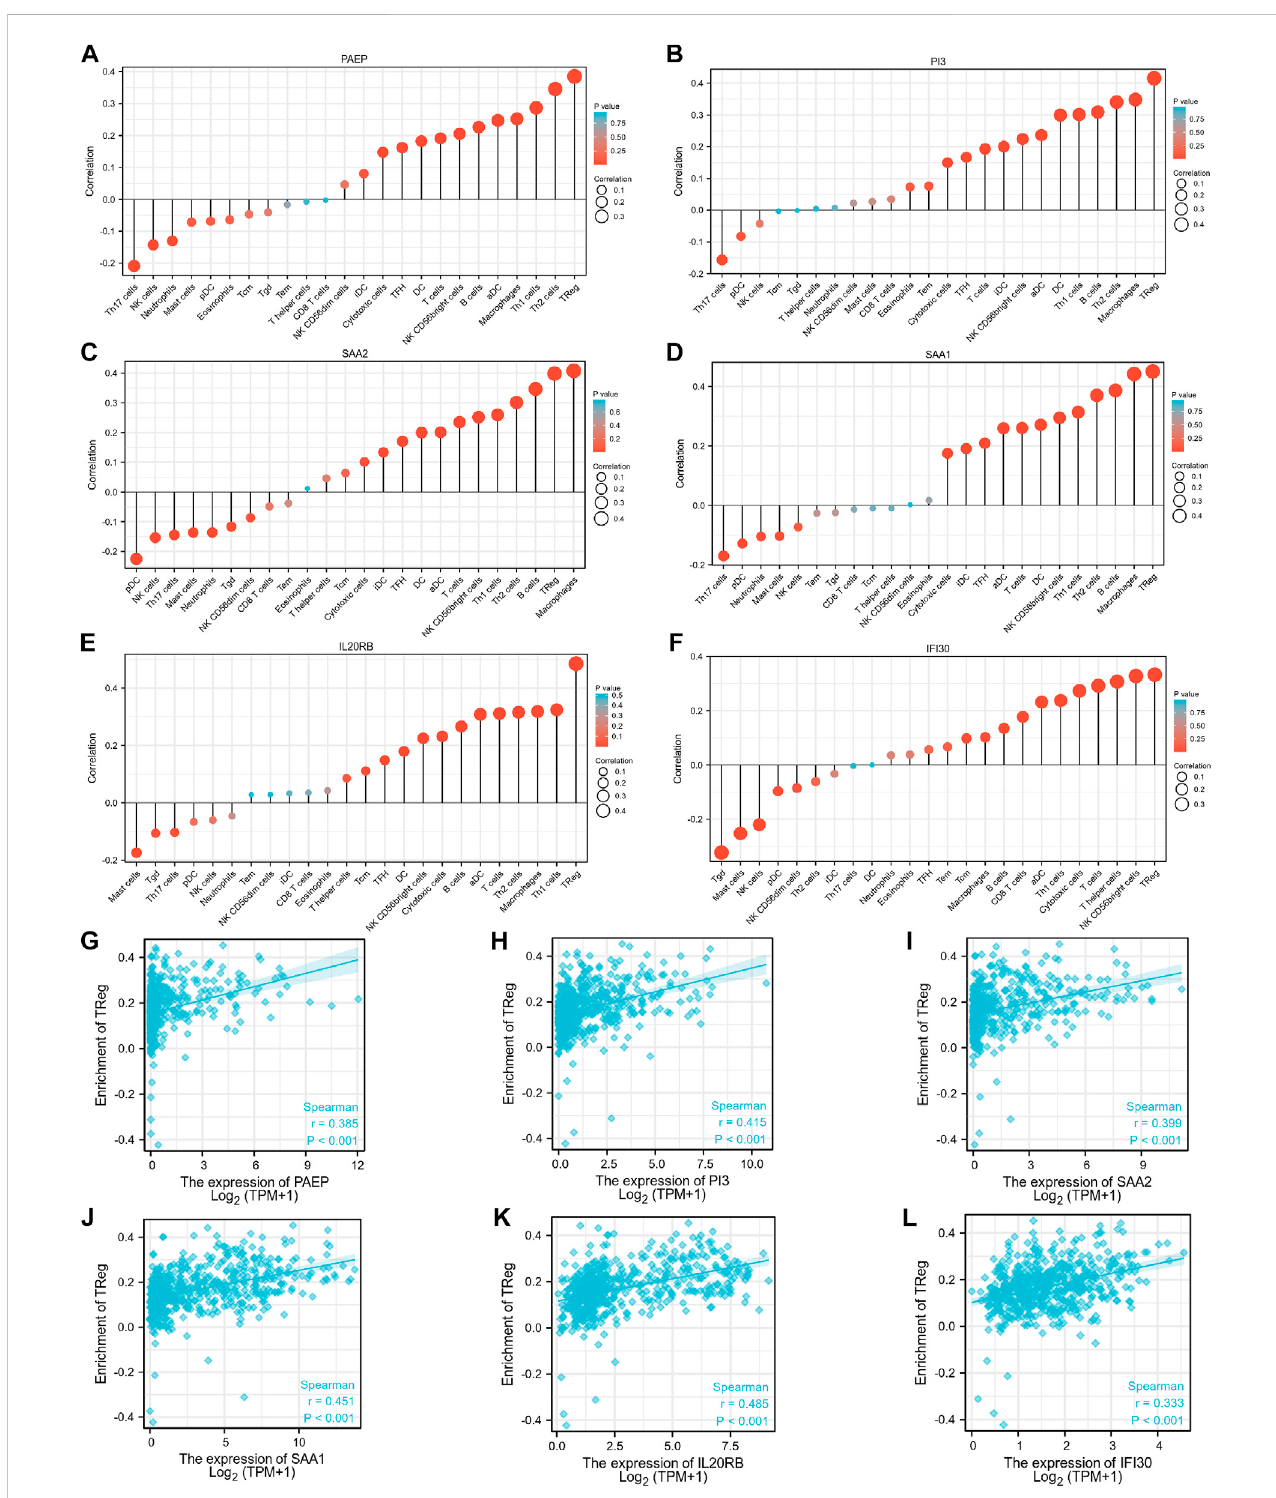
FIGURE 7 Associations between expression levels of the six immunity-related genes and in fi ltrating immune cells in patients with KIRC. (A – F) The associations between the expression levels of PAEP, PI3, SAA2, SAA1, IL20RB, and IFI30 and in fi ltration by immune cells. (G – L) The associations between expression levels of PAEP, PI3, SAA2, SAA1, IL20RB, IFI30 and in fi ltration by regulatory T cells in KIRC